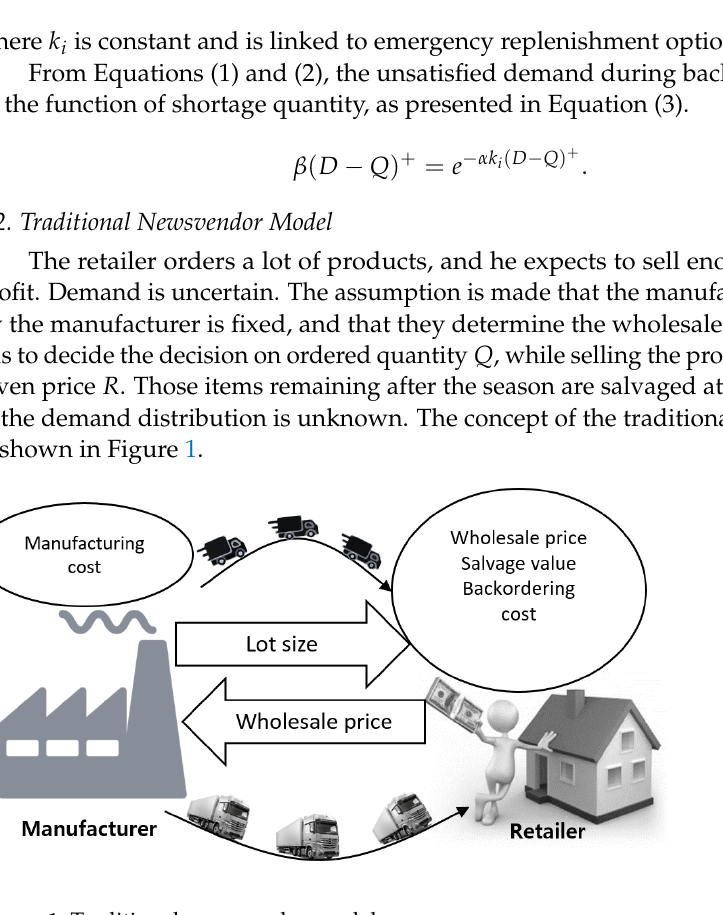
Figure 1. Traditional newsvendor